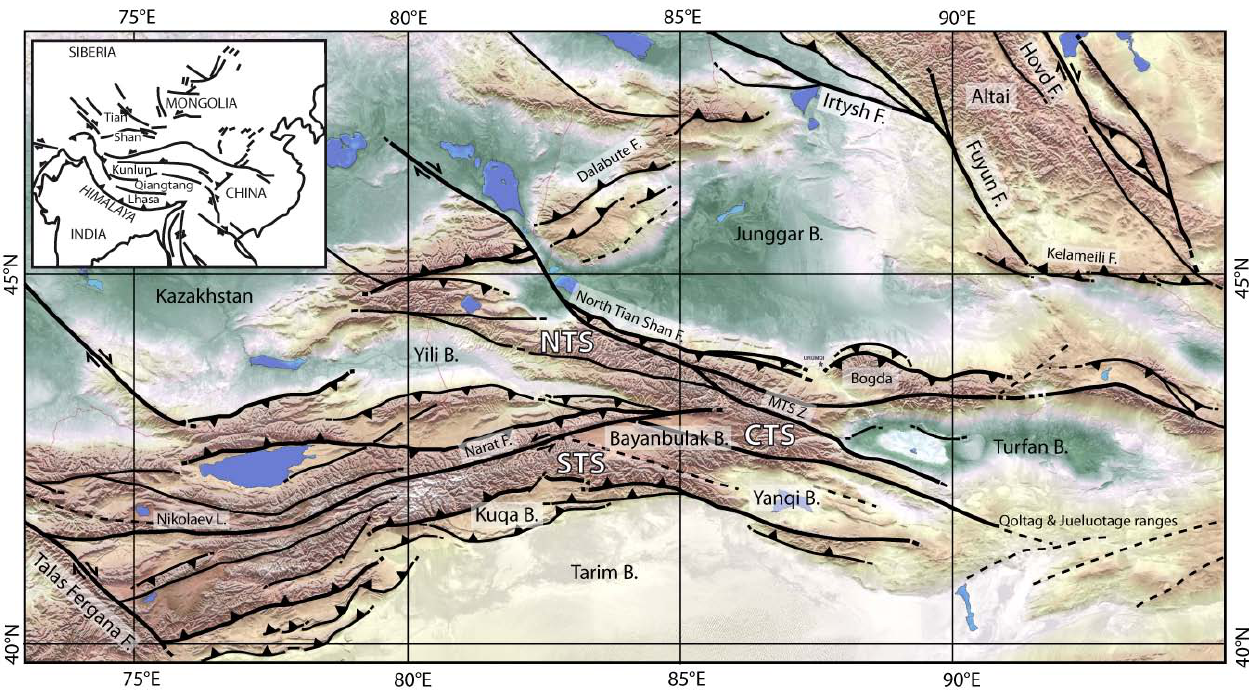
Fig. 1. General topographic and tectonic map of the Tian Shan Range and surrounding areas. MTS Z: Main Tian Shan Shear Zone; B. stands for basin; F. stands for fault. STS: South Tian Shan block. CTS: Central Tian Shan block. NTS: North Tian Shan block. The topography is a courtesy of S.